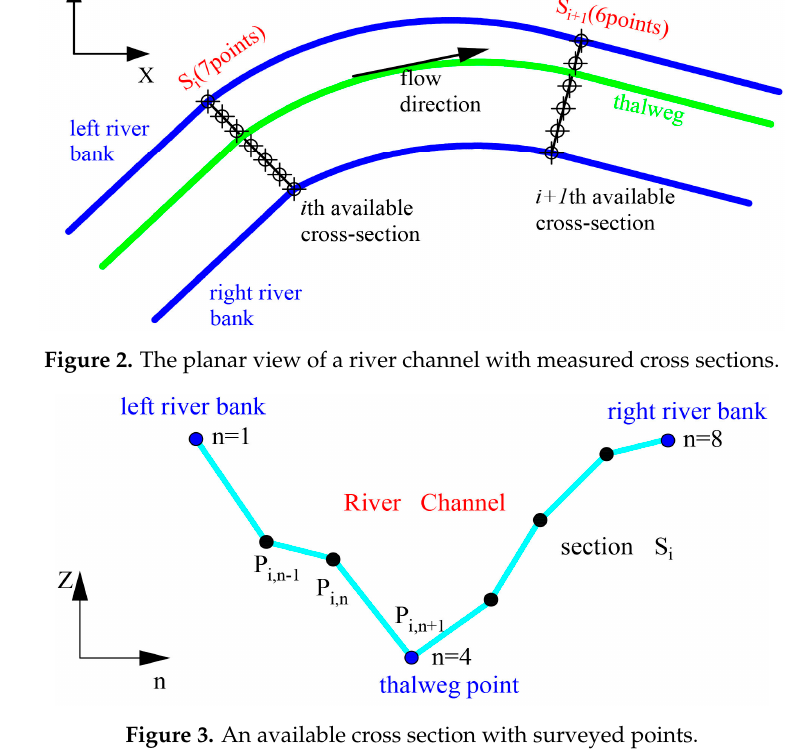
Figure 3. An available cross section with surveyed points.